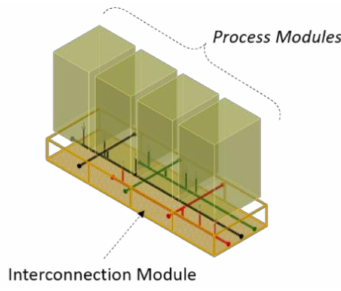
Figure 7. Sketch of the subsea gate box